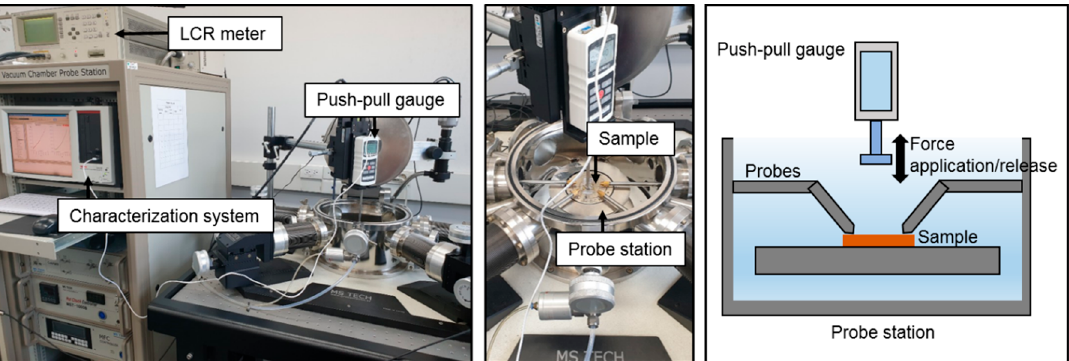
Figure 9. Measurement process of the electrical performance of the air-gap touch sensor: photograph of the entire equipment for measurement ( left ); enlarged photograph of the probe station and a sample ( middle ); and schematic of the measurement equipment ( right ).